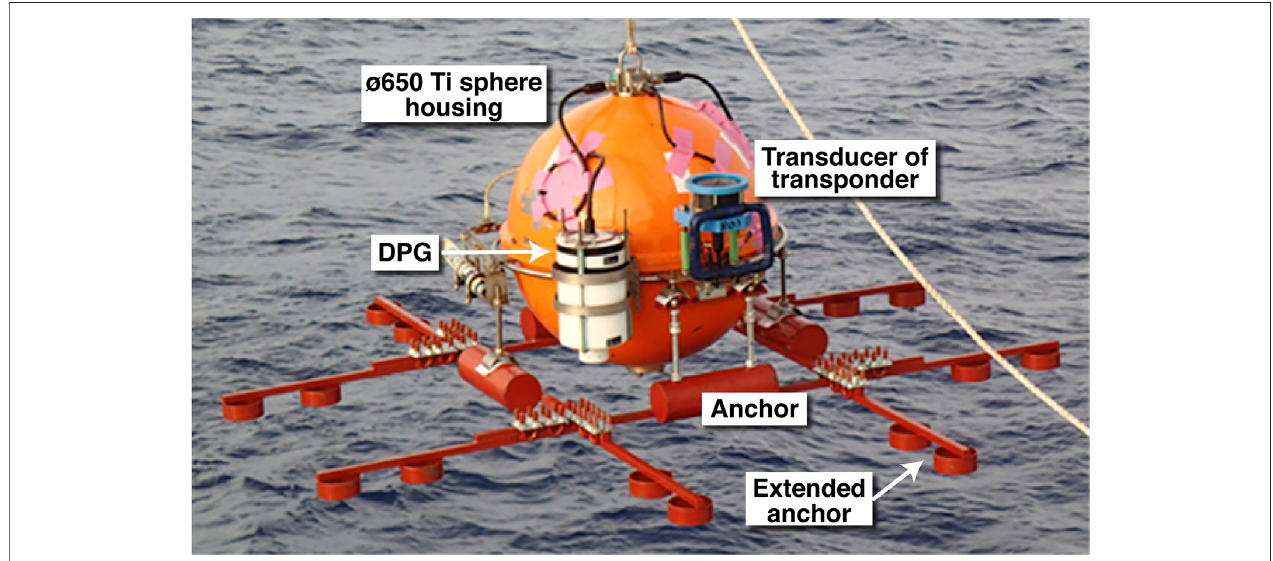
FIGURE 1 | Japanese broadband ocean bottom seismometer (BBOBS). The most recent design of the Japanese BBOBS originally developed in 1999. The broadband sensor inside is the CMG-3T (360 s) mounted on the original leveling system. The anchor base size was 1 m × 1 m. To achieve more stable coupling to the sediment,the “ extendedanchor ” isattachedtoa2 m × 2 mbase.TheDPG(differentialpressuregauge)isnowstandardequipment.Themaximumobservationperiodis now 2 years, and it can be deployed at up to 6,000 m.